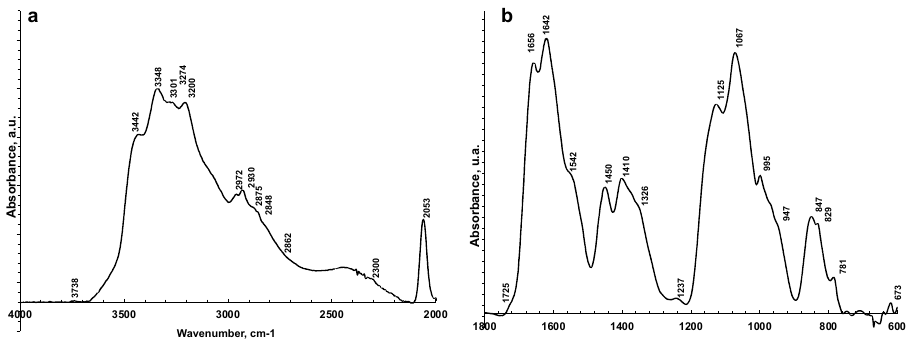
Figure 2. Representative ATR-FTIR spectra of saliva analyzed as is in 4000–2000 cm − 1 ( a ) and 1800–600 cm − 1 regions ( b ).